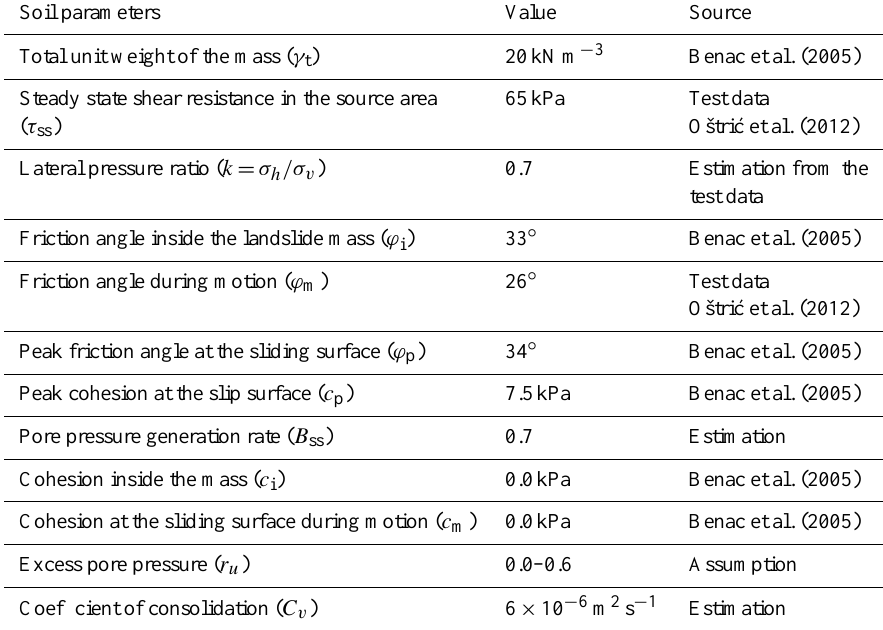
Table 1. Soil parameters used in the SPH computer